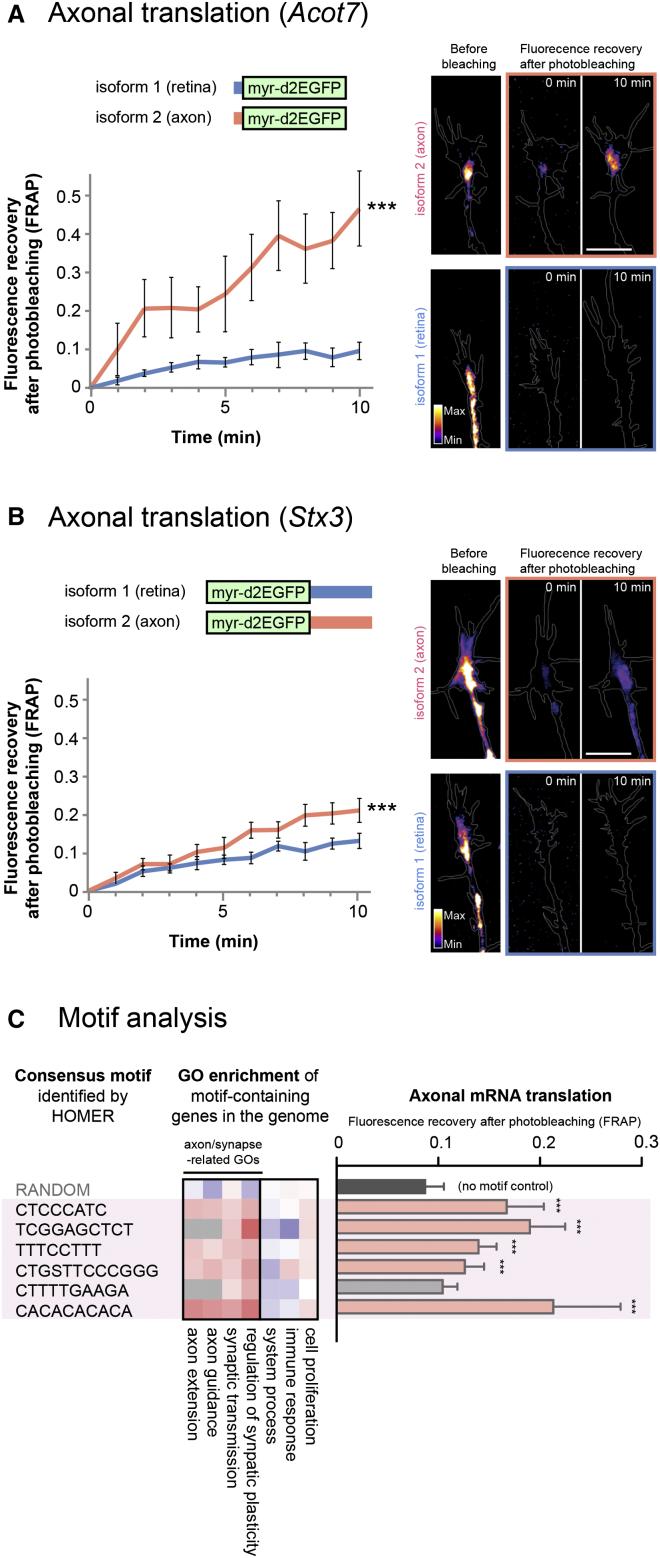
Cis-Regulatory Elements Link Alternative Splicing to Axonal Translation(A and B) Axon- and retina-specific Acot7 and Stx3 UTR isoforms fused with myr-d2EGFP were expressed in cultured RGCs (Xenopus). Quantification of fluorescence intensity after photobleaching (FRAP) revealed axon-specific isoforms of Acot7 (A) and Stx3 (B) markedly increase axonal translation of the myr-d2EGFP reporter construct compared to retina-specific UTR counterparts. Data at each 1 min time point represent the mean fraction of recovery relative to pre- and post-bleach levels ± SEM (n = 9 and 10 for axon and eye-specific 5′ UTR of Acot7, respectively; n = 14 and 14 for axon and eye-specific 3′ UTR of Stx3, respectively). ∗∗∗p < 0.0001; two-way ANOVA. FRAP signal recovery was abolished by 40 μM anisomycin (10 min post-photobleach: Acot7 axon-isoform + anisomycin 0.064 ± 0.028; Stx3 axon-isoform + anisomycin 0.085 ± 0.026). Representative images of RGC axonal growth cones showing fluorescent recovery after photobleaching for each reporter construct are shown (right). The scale bars represent 10 μm.(C) GO enrichment analysis for entire genome containing axon-specific sequence motifs associated with alternative exons (S: G or C) and their relative efficiency in axonal mRNA translation using myr-d2EGFP reporter constructs. Significance of FRAP recovery curves were compared to no UTR control across 10 min (n ≥ 10 for each construct). Statistical significance of FRAP compared to the no-UTR control was tested across all time points (1–10 min) using a two-way ANOVA (∗∗∗p < 0.0001 compared to no-UTR control). For representative purposes, the mean fluorescence recovery at 10 min post-photobleaching is shown. Error bars represent SEM.See also Figure S7.